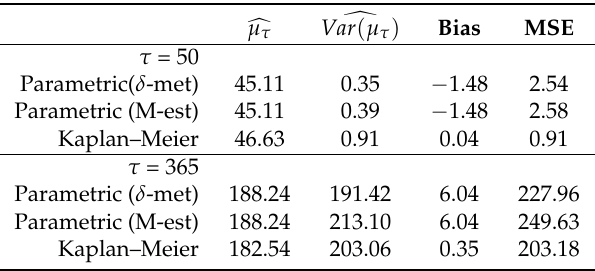
Table 3. Bias and accuracy of the parametric estimation with variance estimated by the δ -method and M-estimation, together with comparative numbers for the Kaplan - Meier method under model misspecification.